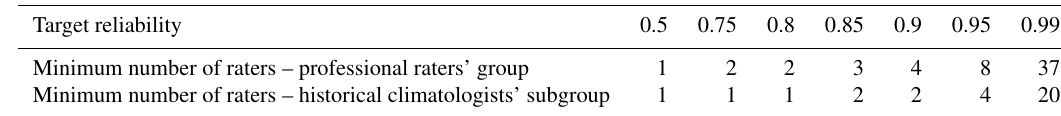
Table 4. Number of raters within the sample of professional raters required to achieve a target value ICC value. Values are provided for all professional raters ( n = 6) and for the subsample of trained historical climatologists ( n =